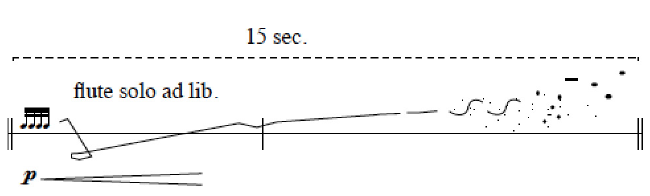
Figure 8. Graphic notation for the flute solo.